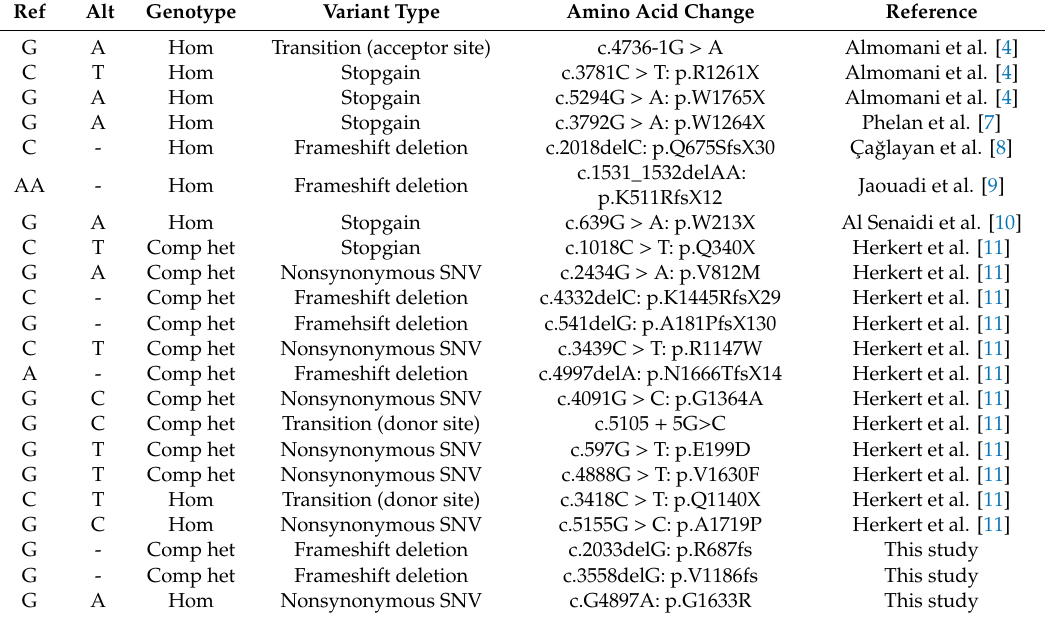
Table 1. Summary of ALPK3 mutations resulting in hypertrophic